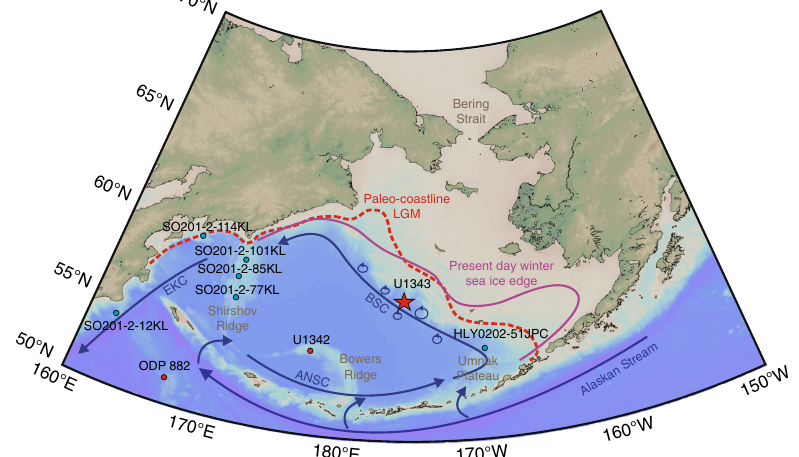
Fig. 1 Overview map of the study location. Map of the Bering Sea showing the location of IODP Site U1343 (red star), U1342 and ODP Site 882 (red dots), together with additional sediment cores (light blue dots) where sea ice reconstructions were performed across Termination I (SO201-2-12KL, SO201-2- 77KL, SO201-2-85KL, SO201-2-101KL, SO201-2-114KL 21, 67 , HLY0202-51JPC 44 ). The pink solid line represents the present day winter sea ice edge, the red dashed line is the Last Glacial Maximum (LGM) coastline 68 , and the blue arrows show the cyclonic surface circulation in the Bering Sea. The Alaskan Stream enters the Bering Sea in the south through several Aleutian passes to form the Aleutian North Slope Current (ANSC) that feeds into the Bering Slope Current (BSC), which in turn feeds into the East Kamchatka Current (EKC) (modi fi ed from Stabeno et al. 60 ). Eddy formation along the eastern Bering slope (blue circles) brings nutrients to the surface resulting in high primary productivity, called the ‘ Green Belt ’ 7 . Map created with Ocean Data View